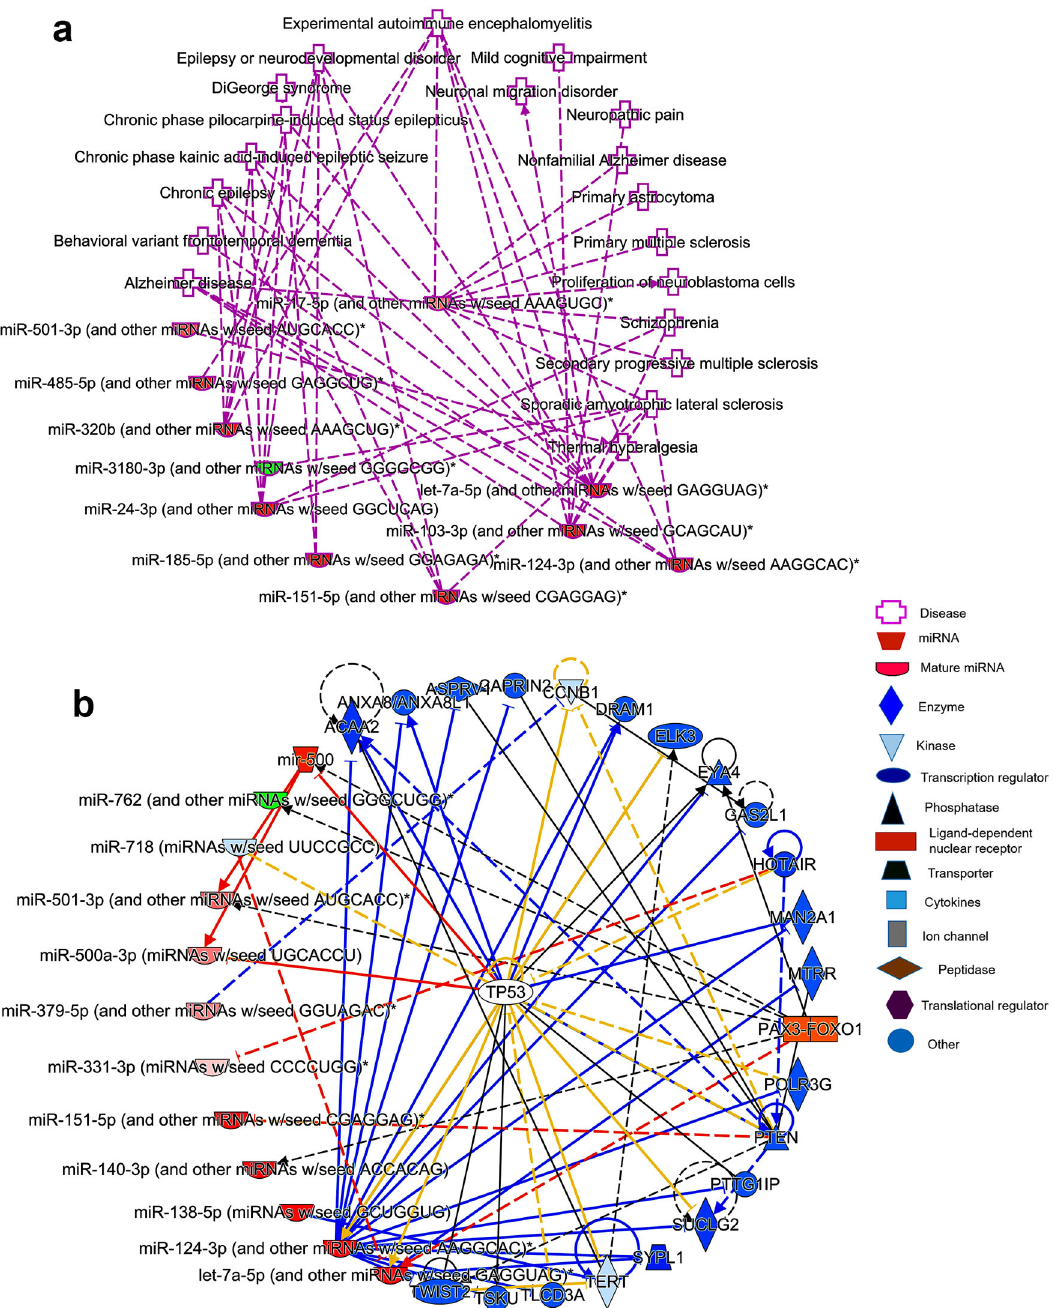
Fig. 5 Ingenuity pathway analysis of cytosolic and synaptosomal miRNAs in AD. a In AD state, cytosolic and synaptosomal miRNAs expression network in various human diseases. Red nodes represent increased expression and green nodes represent a decreased expression of miRNAs. b MiRNAs target and seed sequences network of cytosolic and synaptosomal miRNAs in the AD